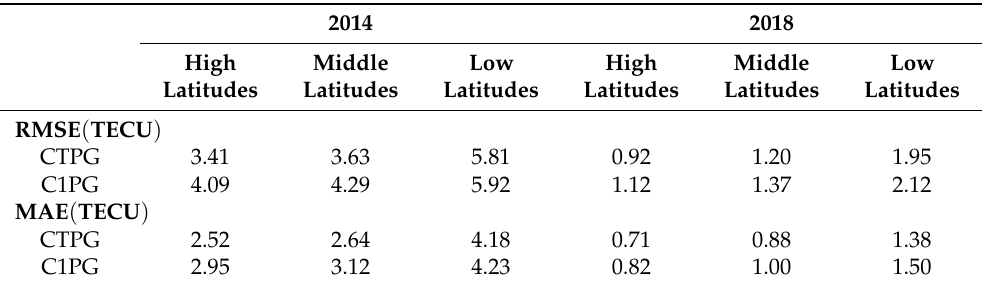
Figure 6. RMSE and MAE values between forecasting TEC maps (CTPG and C1PG) and IGS TEC maps (CODG) at different latitudes in 2014 and 2018. Table 3. RMSE and MAE values between the predicted TEC maps (CTPG and C1PG) and IGS TEC maps (CODG) in different latitude regions in 2014 and